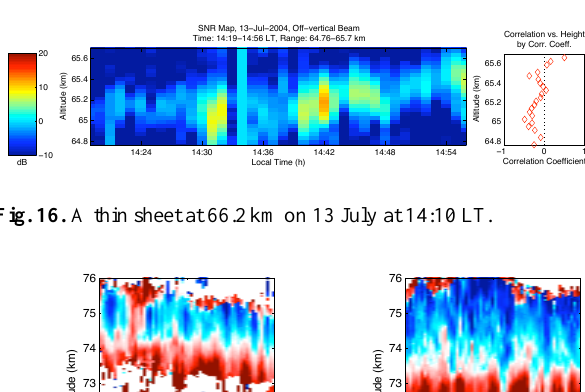
Fig. 15. Thin sheets at 60 km on July 14 at 12:27 LT.